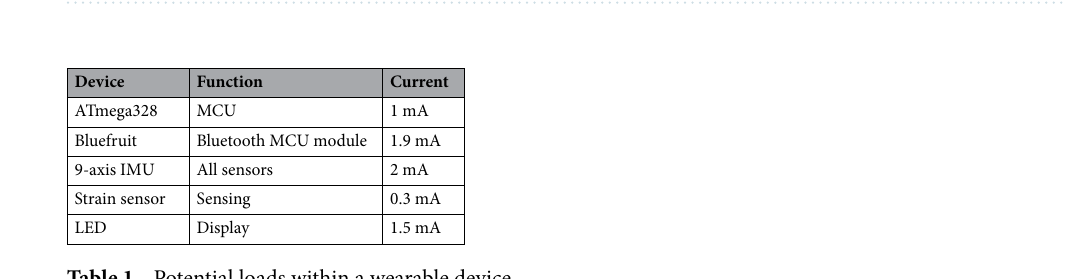
Table 1. Potential loads within a wearable